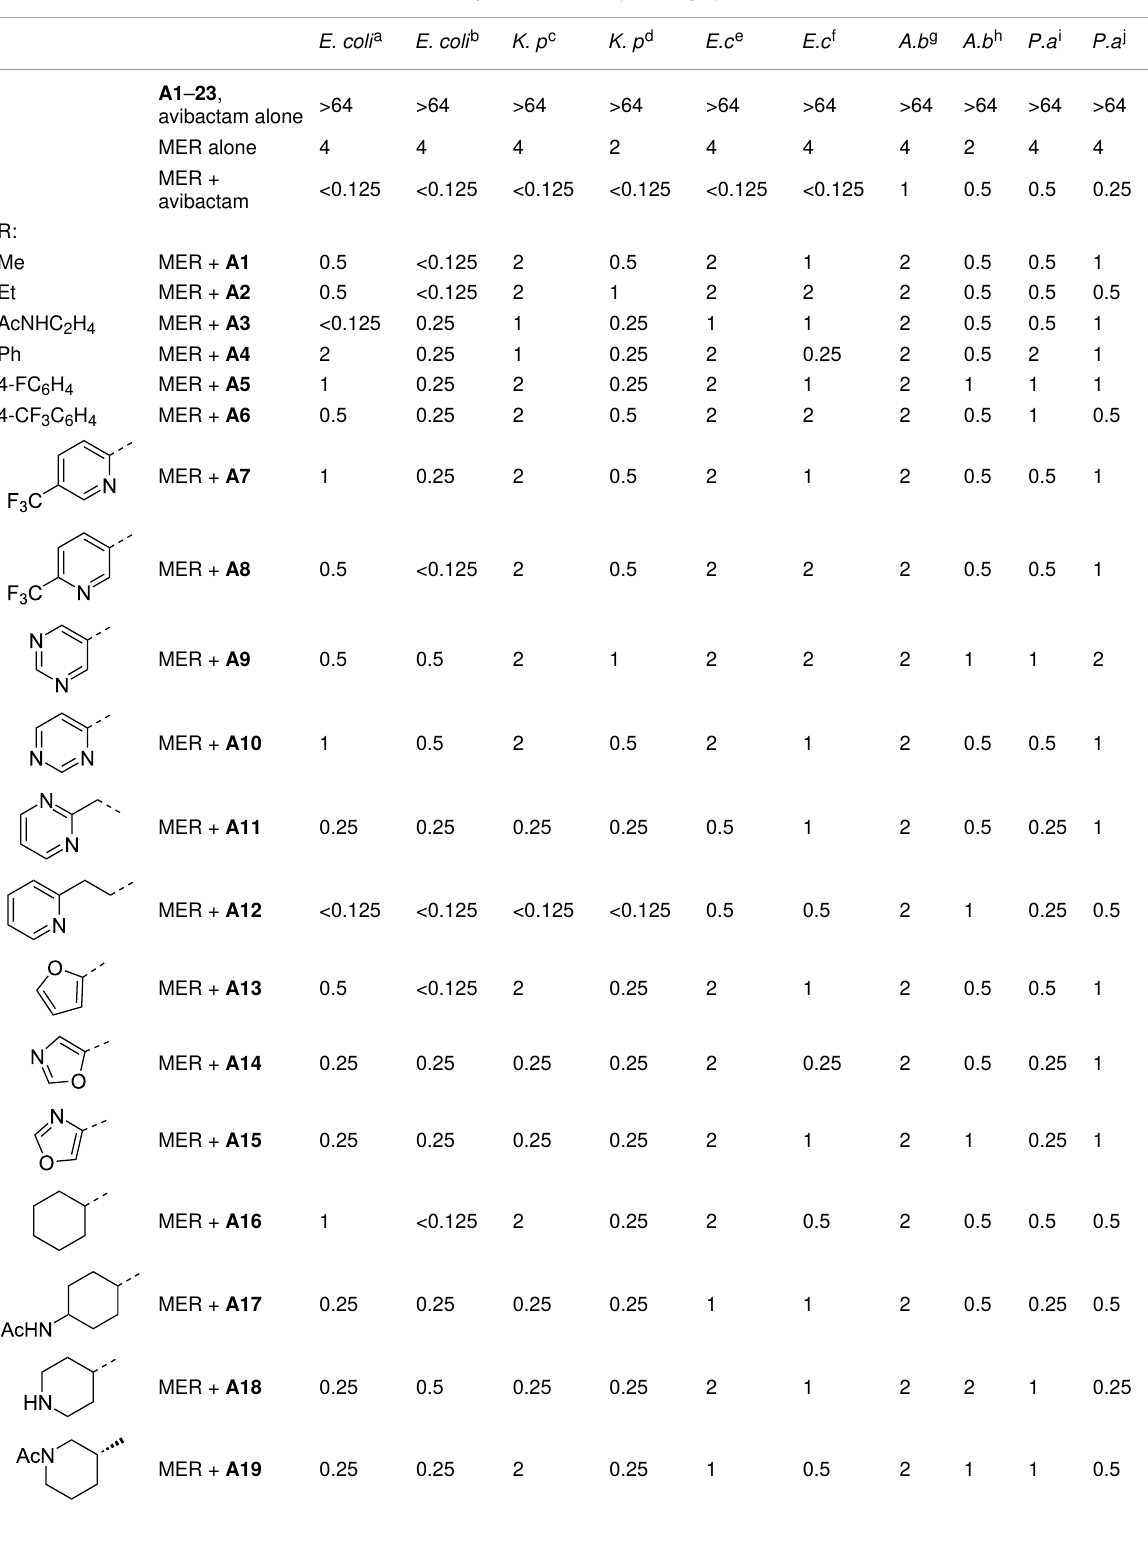
Table 1: In vitro antibacterial activity of avibactam and compounds A1-23 alone as well as in combination with meropenem